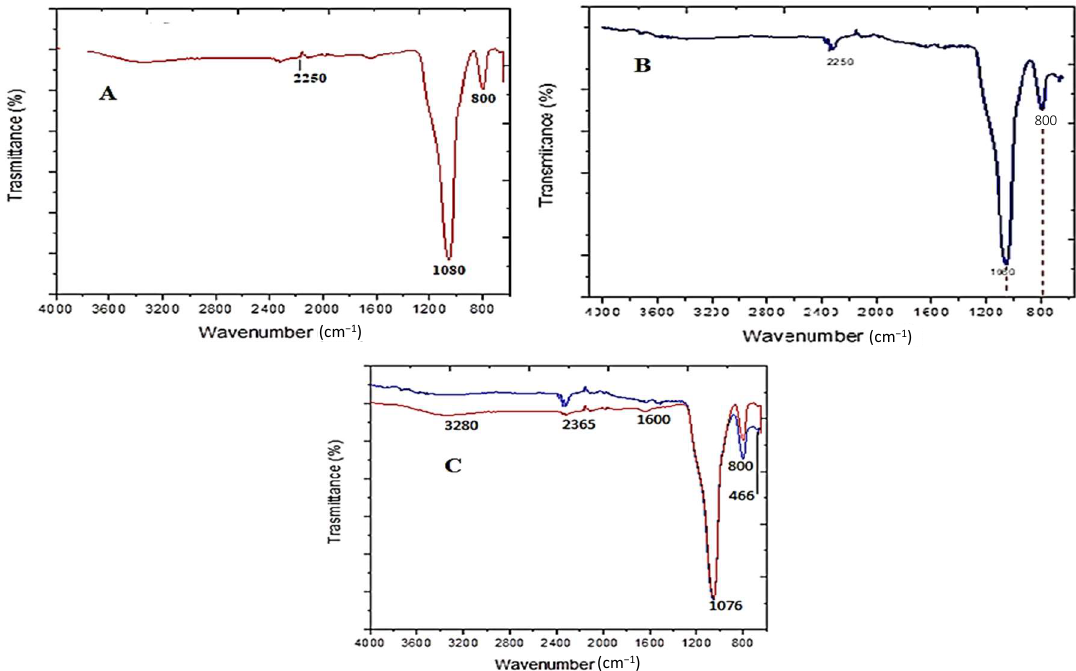
Figure 4. FTIR images of synthesized silica nanoparticles for ( A ) barley husk, ( B ) barley grass, ( C ) barley and wheat and barley and wheat grass.